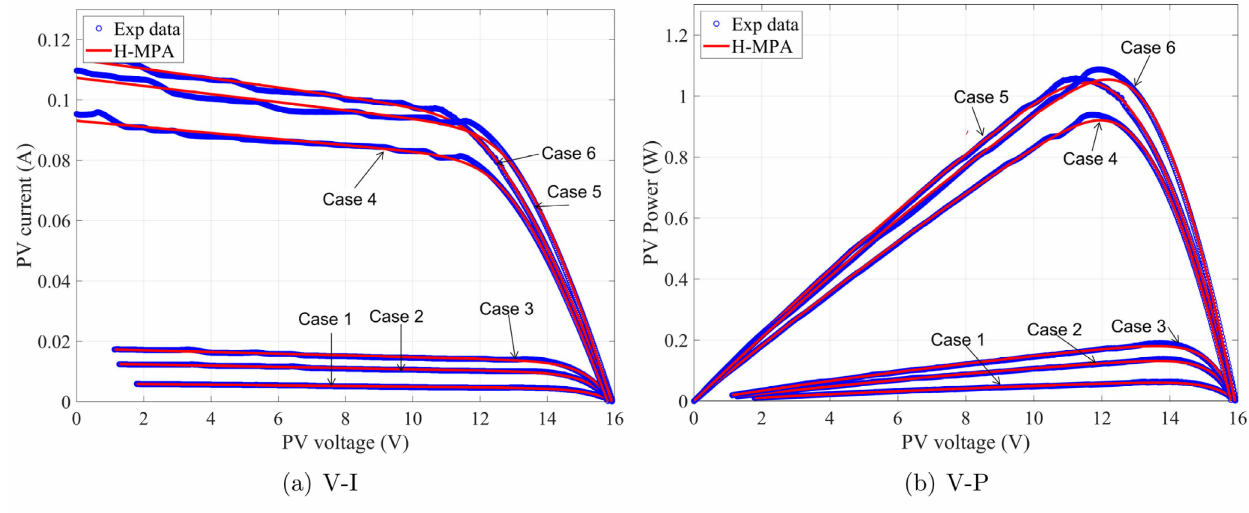
Figure 8. The characteristics of the DSSCs module under different environmental conditions ( a ) I-V relationships, and ( b ) P-V